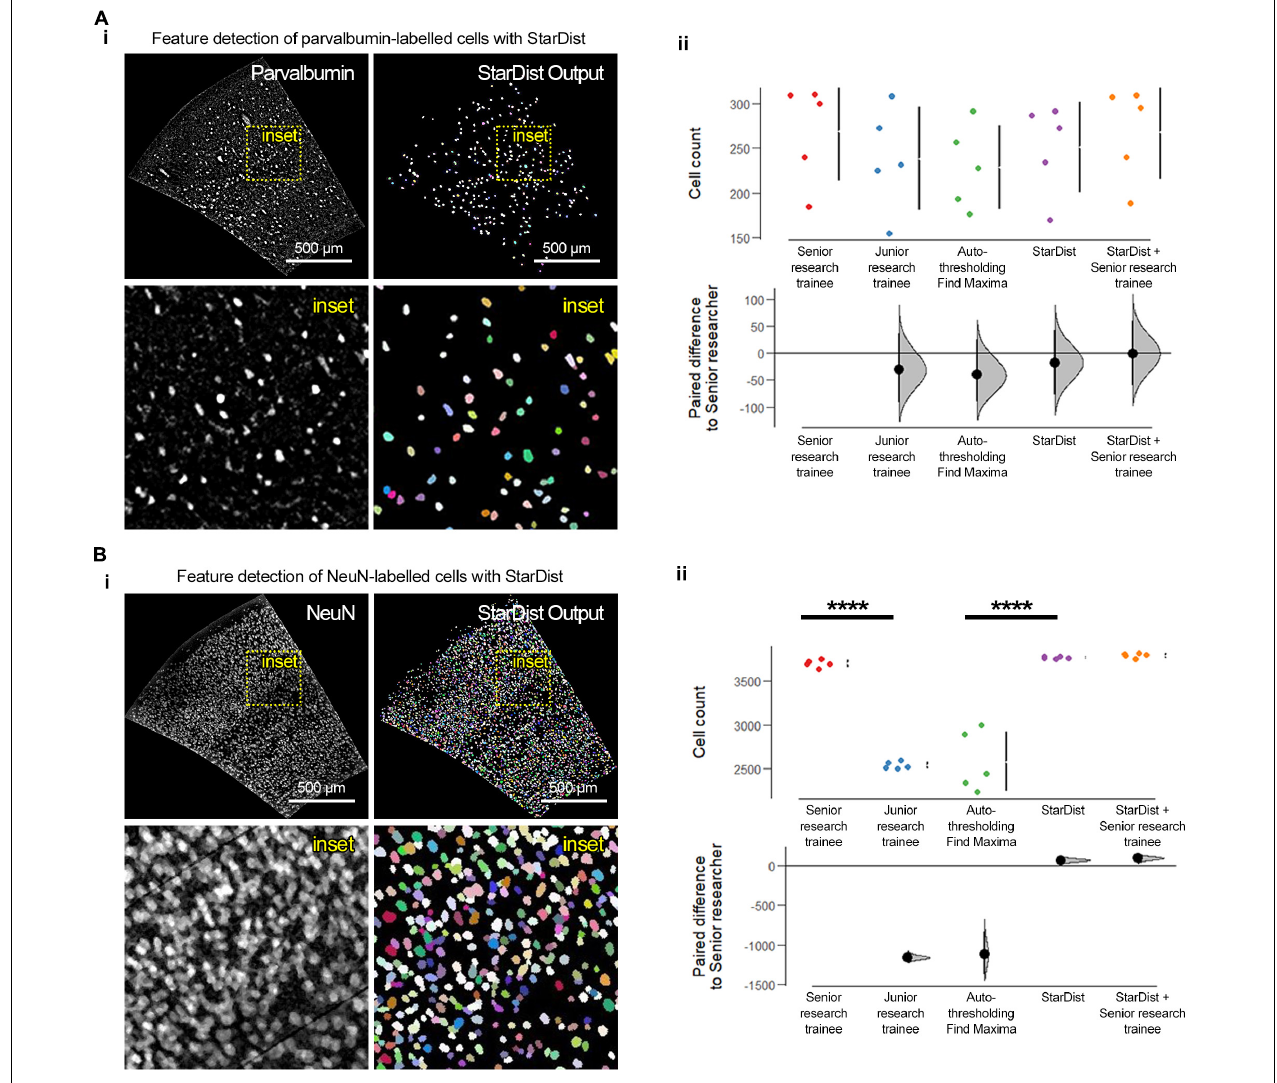
FIGURE 3 | Feature extraction, segmentation, and quantification using “ StarDist ” and other conventional and manual approaches. (A) (i) Representative fluorescence micrographs of the barrel cortex with parvalbumin-labeled cells and “ StarDist ” color-coded annotating output of segmented objects. (ii) “ StarDist ” was as accurate as a senior research trainee in detecting the number of parvalbumin-labeled cells. Note the similar distribution of the data points between “ StarDist, ” the manual quantification by a senior research trainee, and the two methods combined (“ StarDist, ” mean: 251 ± 50.6 cells; senior research trainee, mean: 268 ± 55.1 cells; “ StarDist ” + senior research trainee: 267.8 ± 52.71 cells; mean ± standard deviation; p = 0.694; d = –17.8 [95CI –77.8; 42.8]; d = –1 [95CI –60.8; 60.4]). (B) (i) Representative fluorescence micrographs of the barrel cortex with NeuN-labeled cells and “ StarDist ” color-coded annotating output of segmented objects. (ii) As expected, using labeling with NeuN results in images with high cellular density, which are significantly challenging for inexperience research trainees and conventional thresholding approaches ( p < 0.0001). “ StarDist ” significantly outperformed the autothresholding and “ Find Maxima ”-based conventional approaches in detecting, segmenting, and quantifying labeled cells (“ StarDist, ” mean: 3765.8 ± 13.3 cells; autothresholding /“ Find Maxima, ” mean: 2580.4 ± 339.8 cells; p < 0.0001; d = 1190 [95CI 907; 1440]). “ StarDist ” performance was similar to that of the manual quantification by a senior research trainee or the two combined, albeit with lower variability (senior research trainee, mean: 3698.6 ± 40.1 cells; “ StarDist ” + senior research trainee, mean: 3789 ± 25.7; p = 0.9570; d = –17.8 [95CI –77.8; 42.8] and d = –1 [95CI –60.8; 60.4], respectively). N = 5 randomly selected barrel cortex micrographs; “****” p < 0.0001. For experimental details regarding the animals used and image acquisition and processing parameters see Supplementary Methods